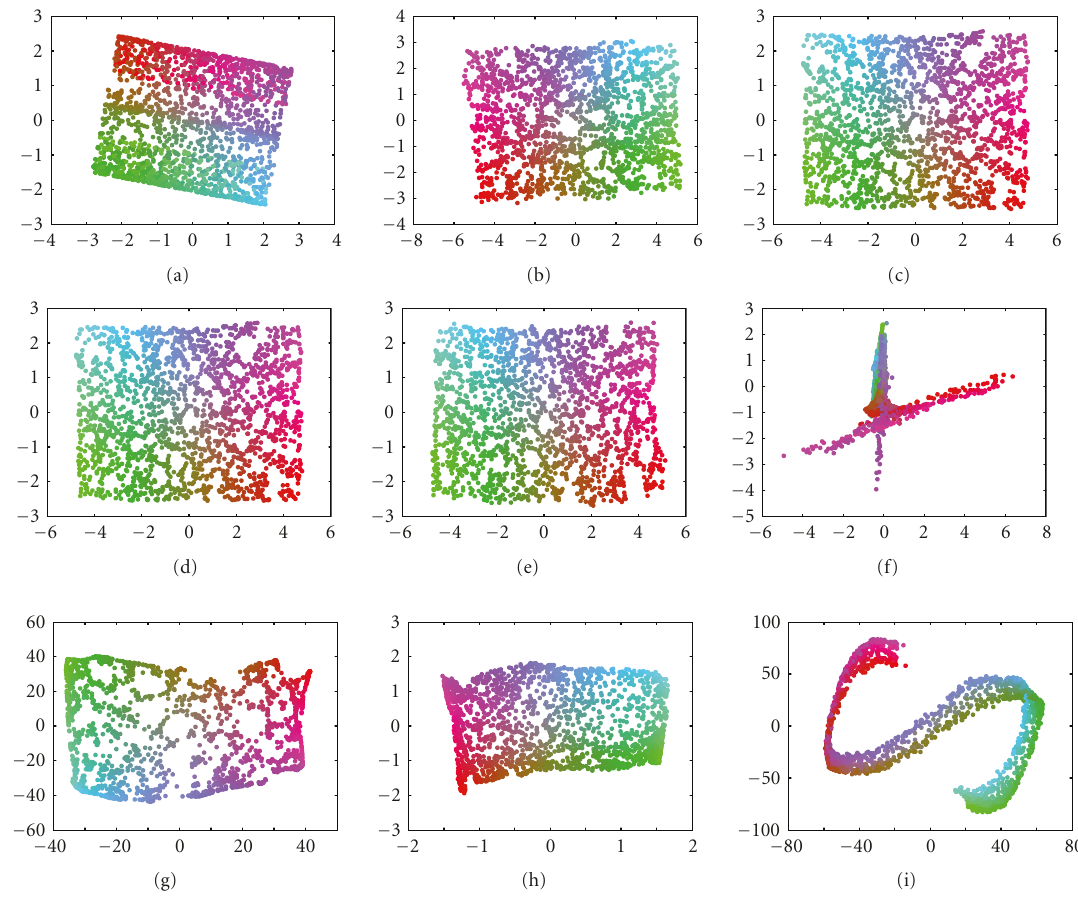
Figure 3: Reduced space computed by (a) PCA, (b) Isomap, (c) S P , (d) S SAM , (e) S CCA , (f) locally linear embedding, (g) Laplacian eigenmap, (h) Hessian eigenmap, and (i) di ff usion maps for the noisy SCurve (Gaussian noise, 5%